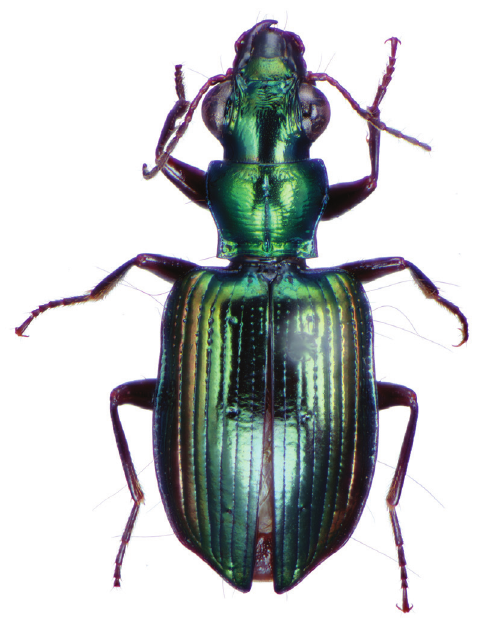
Figure 28. Dorsal habitus and color pattern of Catascopus ( s. str. ) viridiorchis sp. n.. (OBL 9.0